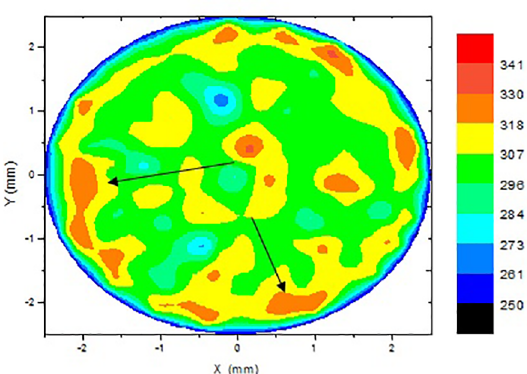
Figure 9. Hardness Map of 8 pass specimen with 0.1 pressing velocity, 300 C pressing temperature and route